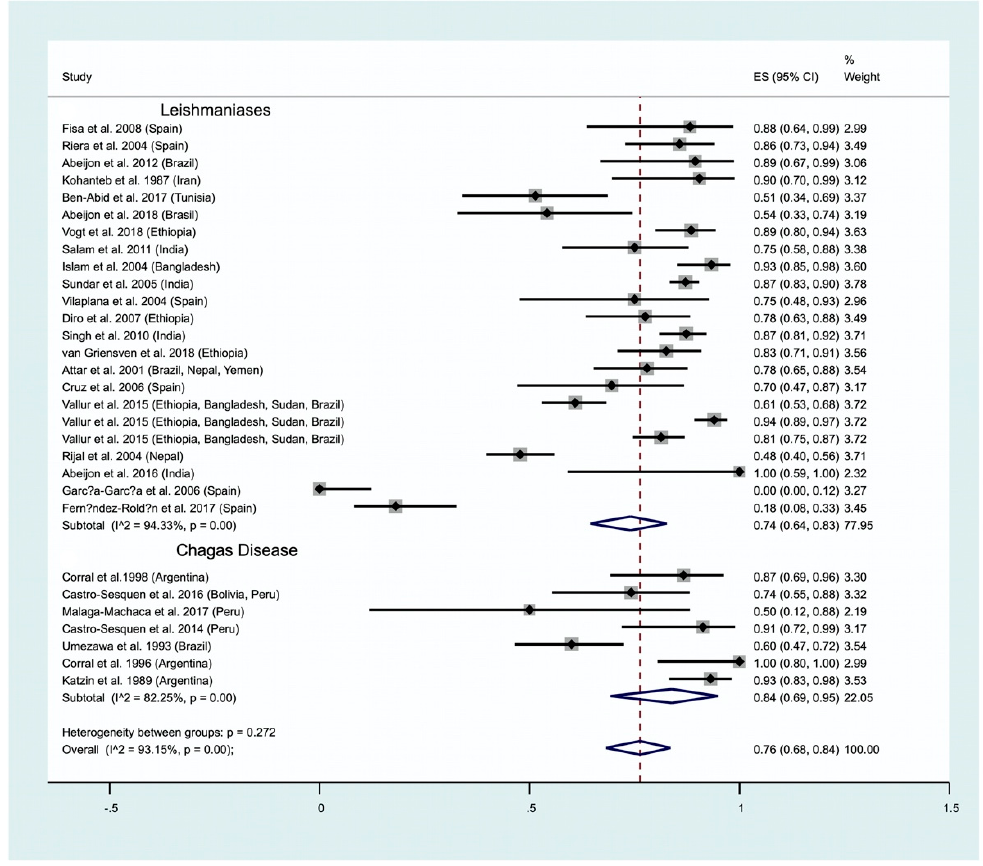
Figure 6. Forest plot representation of the extracted data for urine analysis using antigen detection methods with subgroup analysis on human leishmaniasis and Chagas disease.